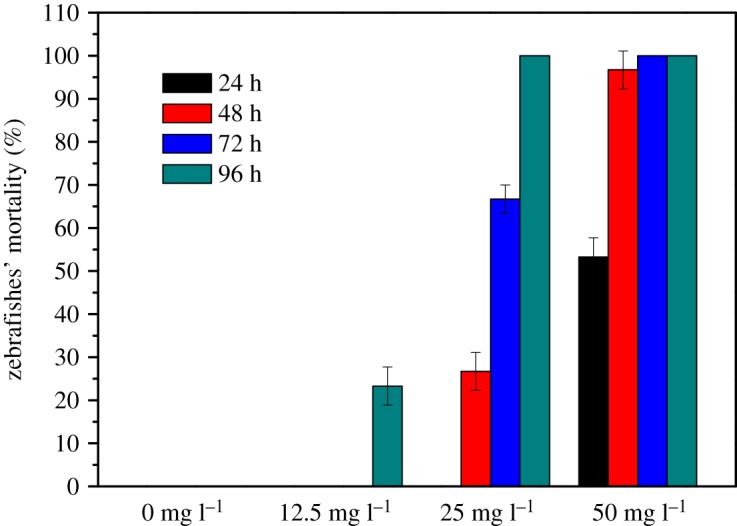
Mortality of zebrafishes in the solution with different Tb–TiO2 concentrations.